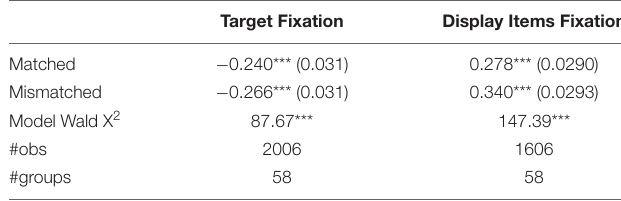
TABLE 2 | Mixed effects regressions of total fixation times detected in target or display item